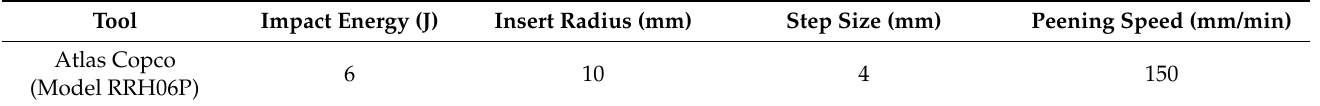
Table 2. Interlayer hammer peening parameters for single bead WAAM